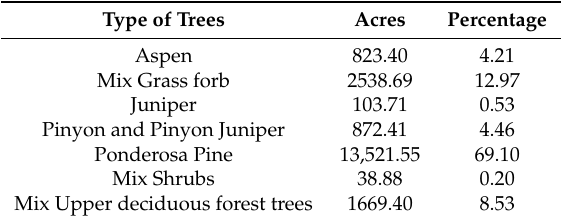
Table 1. Landcover types and percentage in area of